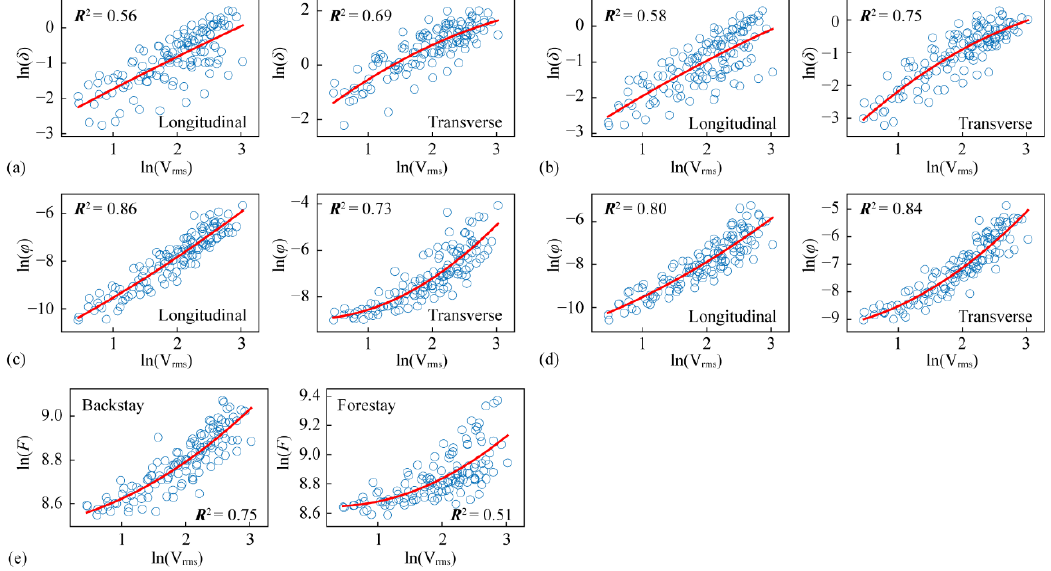
Figure 9. PSDMs for different components: ( a ) bearing at girder–pier location; ( b ) bearing at girder– pylon location; ( c ) Section 1 of the pylon; ( d ) Section 3 of the pylon; and ( e ) cables. Table 7. Regression coefficients for the PSDMs.